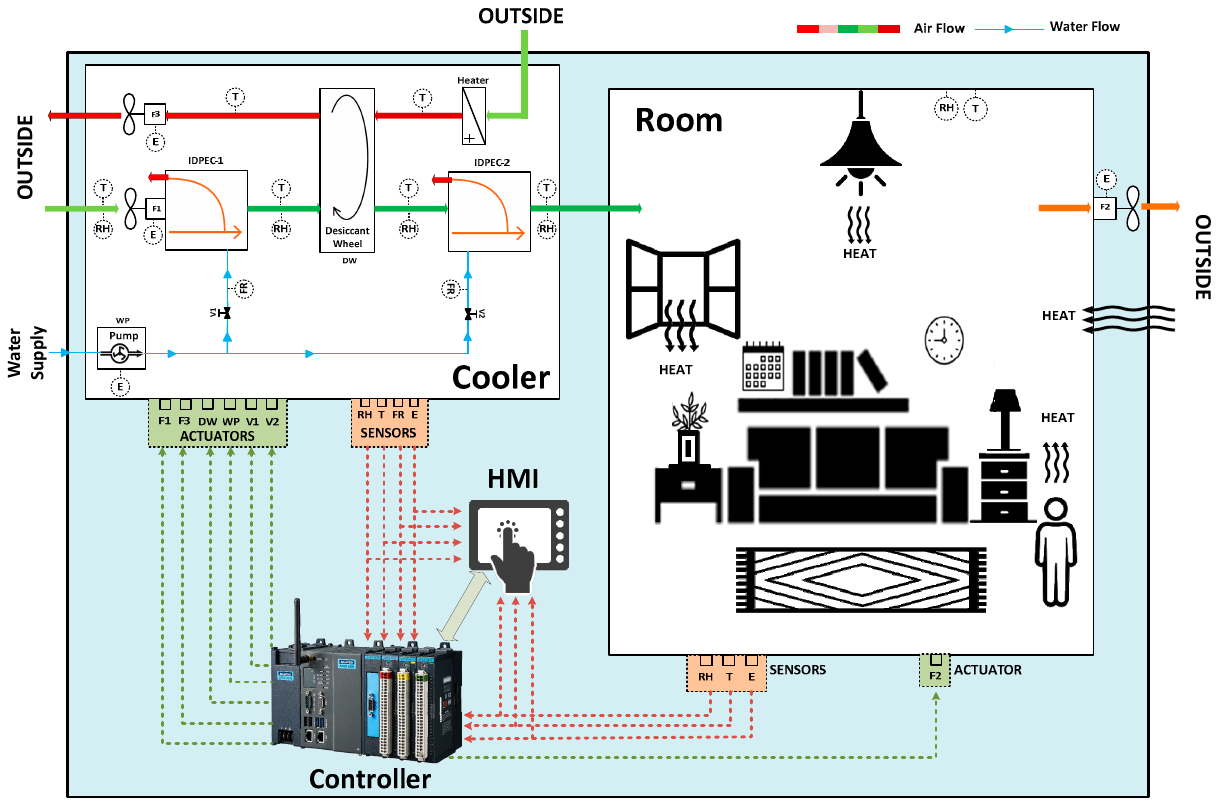
Figure 1. A scheme of the proposed independent controlled pre-cooled desiccant cooling system .